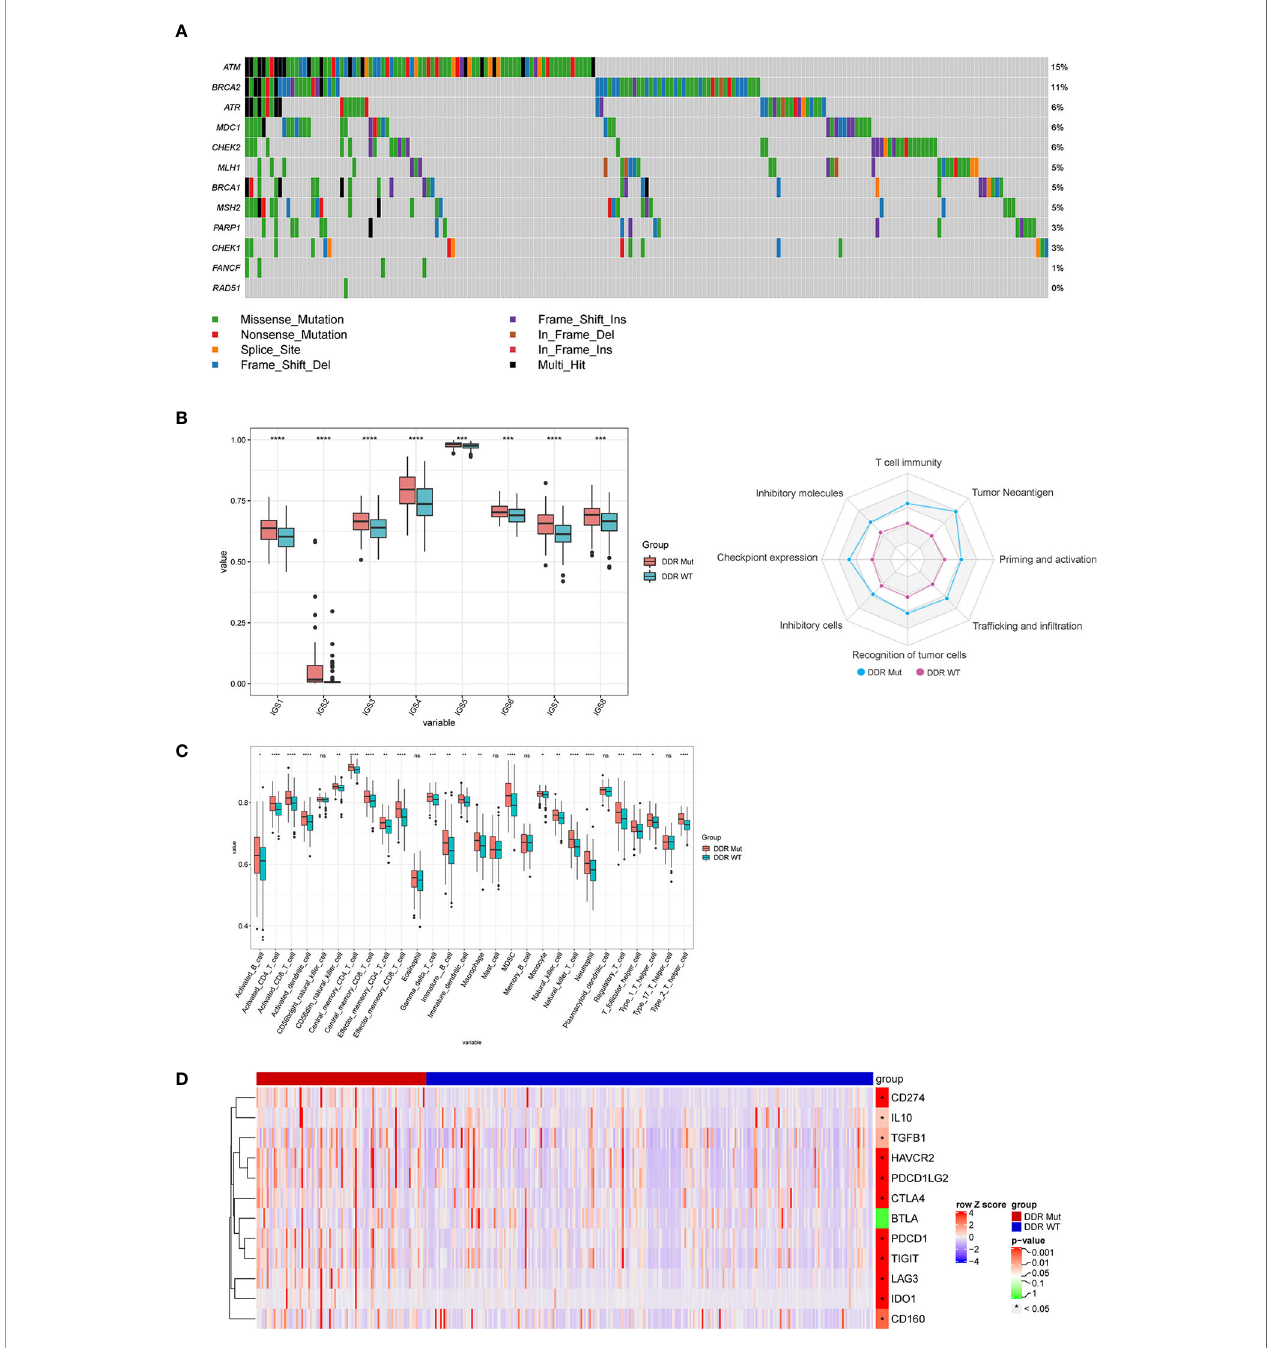
FIGURE 4 | DNA damage repair (DDR) mutation improves the ef fi cacy of immune checkpoint inhibitor (ICI) immunotherapy via regulation of the immune microenvironment. (A) The mutation frequency of 12 DDR genes in the The Cancer Genome Atlas (TCGA) colorectal cancer cohort was derived from the TCGA website. (B – D) Comparison of (B) immune cycle, (C) 28 immune cell subsets, and (D) 12 immune checkpoint negative regulators between the DDR Mut and WT groups. ns P>0.05, *P<0.05, **P<0.01, ***P<0.001,